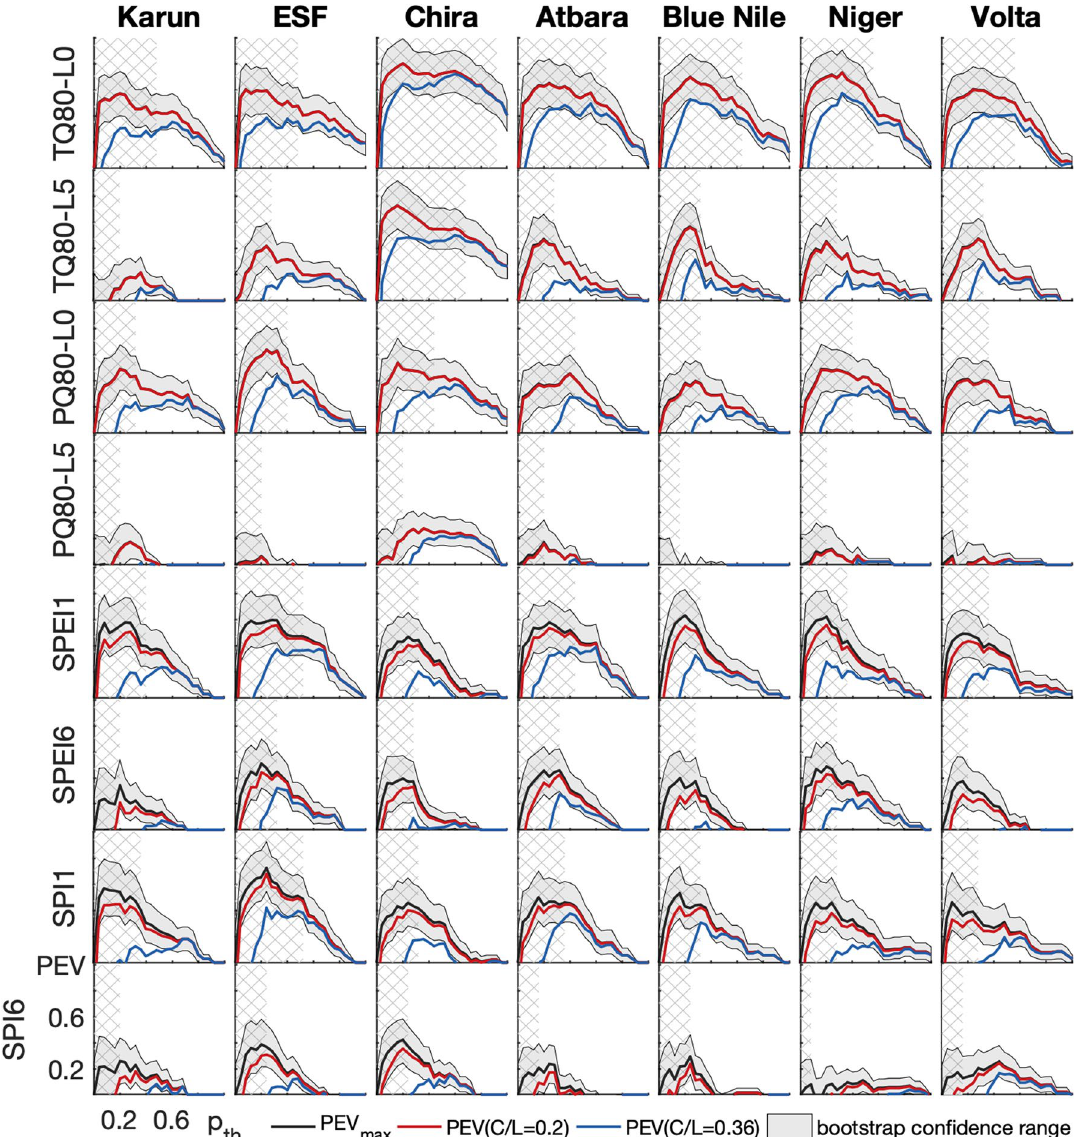
Figure 5. Maximum potential economic value as a function of probability threshold. PEV max of SEAS5 with reference ERA5 is depicted for extreme events of the seven river basins for rainy seasons of the hindcast period 1981-2016 (black line). The uncertainty of the estimation of PEV max is assessed with the confidence range between the 10% and 90% quantiles of bootstrap resampling (shaded area). The red and blue lines denote the PEV for cost-loss ratios of 0.2 and 0.36, respectively. The extreme events include T > Q 80 and P > Q 80 for leadmonths 0 (L0) and 5 (L5), as well as SPEI < − 1 and SPI < − 1 for aggregation scales over one (SPI1/SPEI1) and 6 months (SPI6/SPEI6). The cross-hatched area further represents where the hit rate H > 0.5 to base the choice of p th on the event maximization criterion. Note: From its definition, PEV max represents the PEV when the cost-loss ratio C / L is equal to the climatological frequency of the event (see Equation 2), as in this special case both options of never or always acting create the same expense. Climatology can not advise the decision maker and any forecast is of maximum value. The climatological frequency of a Q80-event and SPI/SPEI < − 1 is 0.2 and 0.159, respectively. Therefore, PEV ( C / L = 0.2 ) (red line) and PEV max (black line) for the Q80-events overlap and accordingly cannot be seen